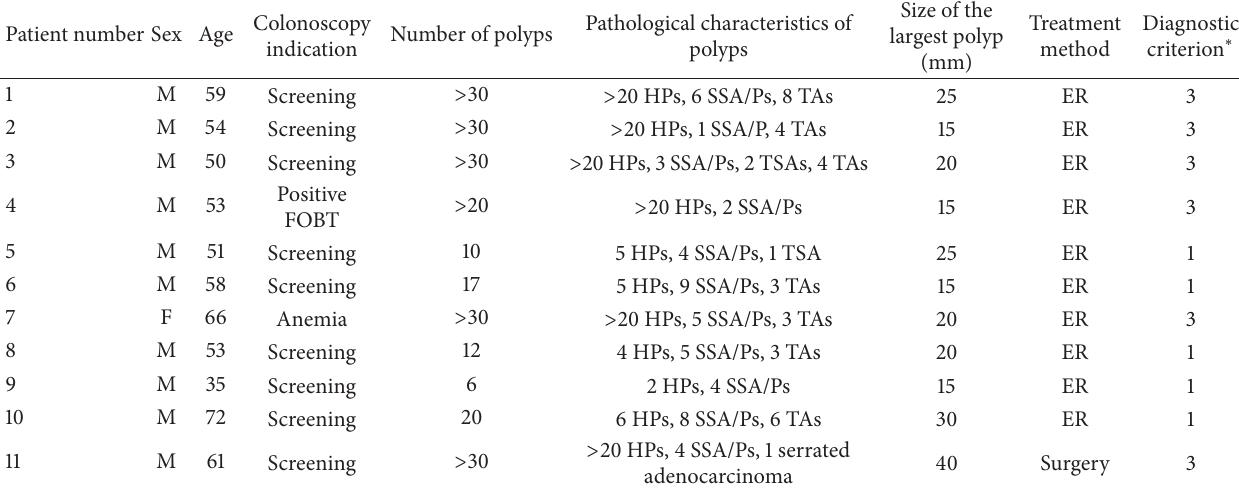
Table 1: Demographic data and clinicopathologic characteristics of patients with serrated polyposis syndrome. Colonoscopy Patient number Sex Age